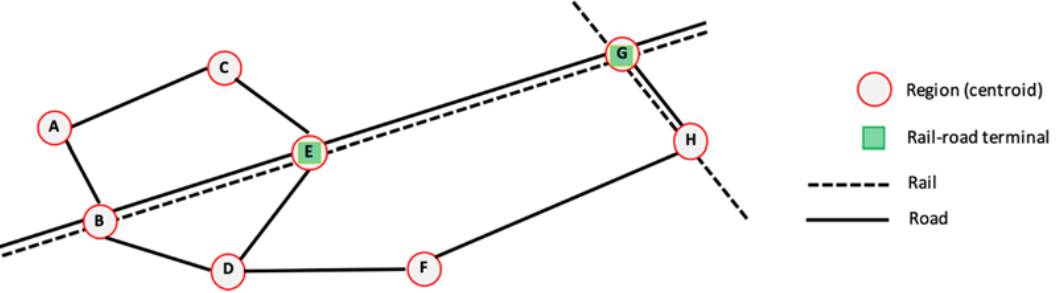
Figure 3. Rail-road network scheme.